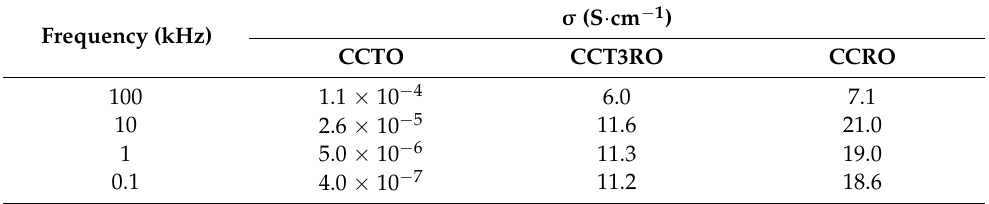
Table 3. Dependence of the electrical conductivity and the frequency value at room temperature.